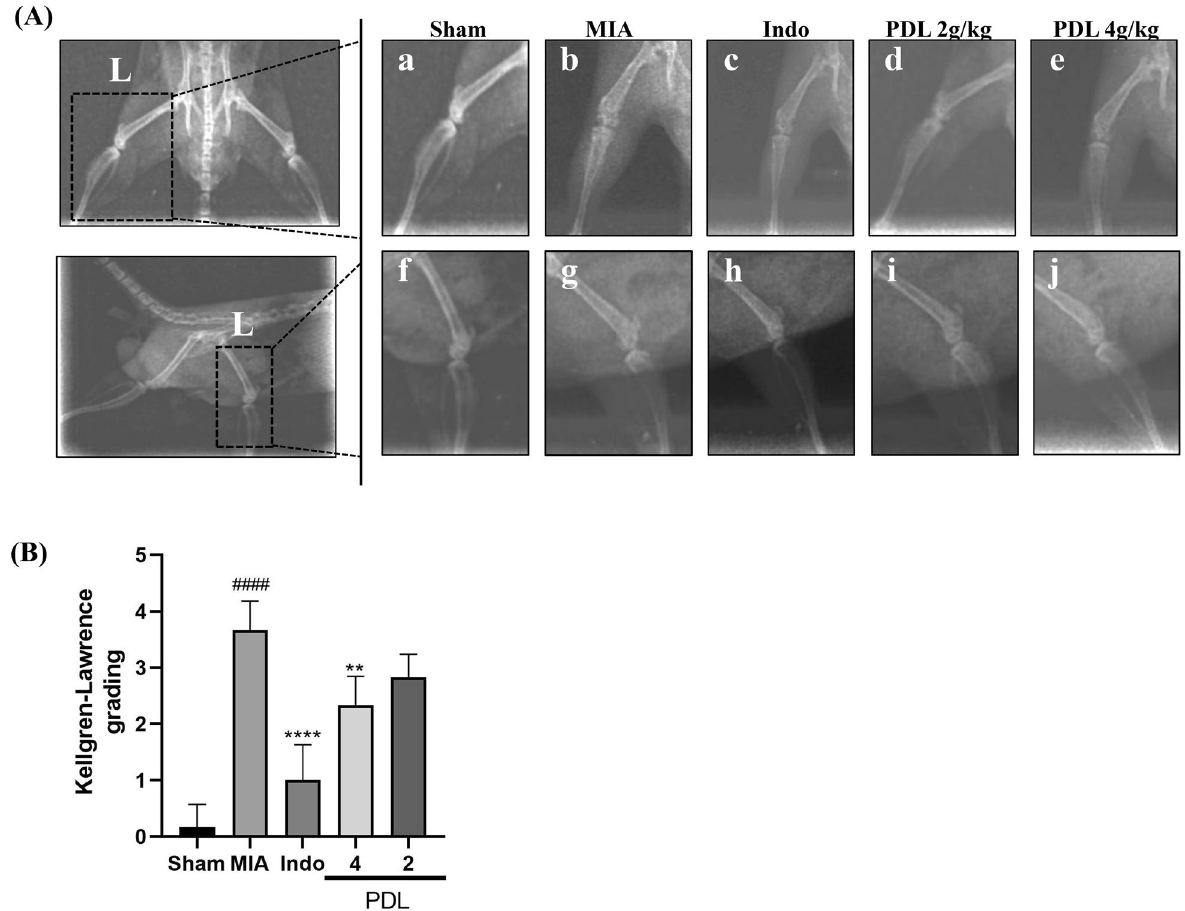
Figure 4. Effects of PDL as quantitatively assessed by X-ray imaging in the MIA induced OA mice model. ( A ) Representative radiographs of the left knee (L) in the sham (sham), sodium iodoacetate (MIA), MIA + indomethacin and PDL groups after day 28 of treatment. Anteroposterior (a, b, c, d, and e) and lateral (f, g, h, i, and j) radiographs of the knee joint in mice. ( B ) Results of KL grade scoring for each group. The data were present as mean ± SD. (n = 5, ####p < 0.0001 compared with the Sham group. **p < 0.01, ****p < 0.0001 compared with the MIA group).